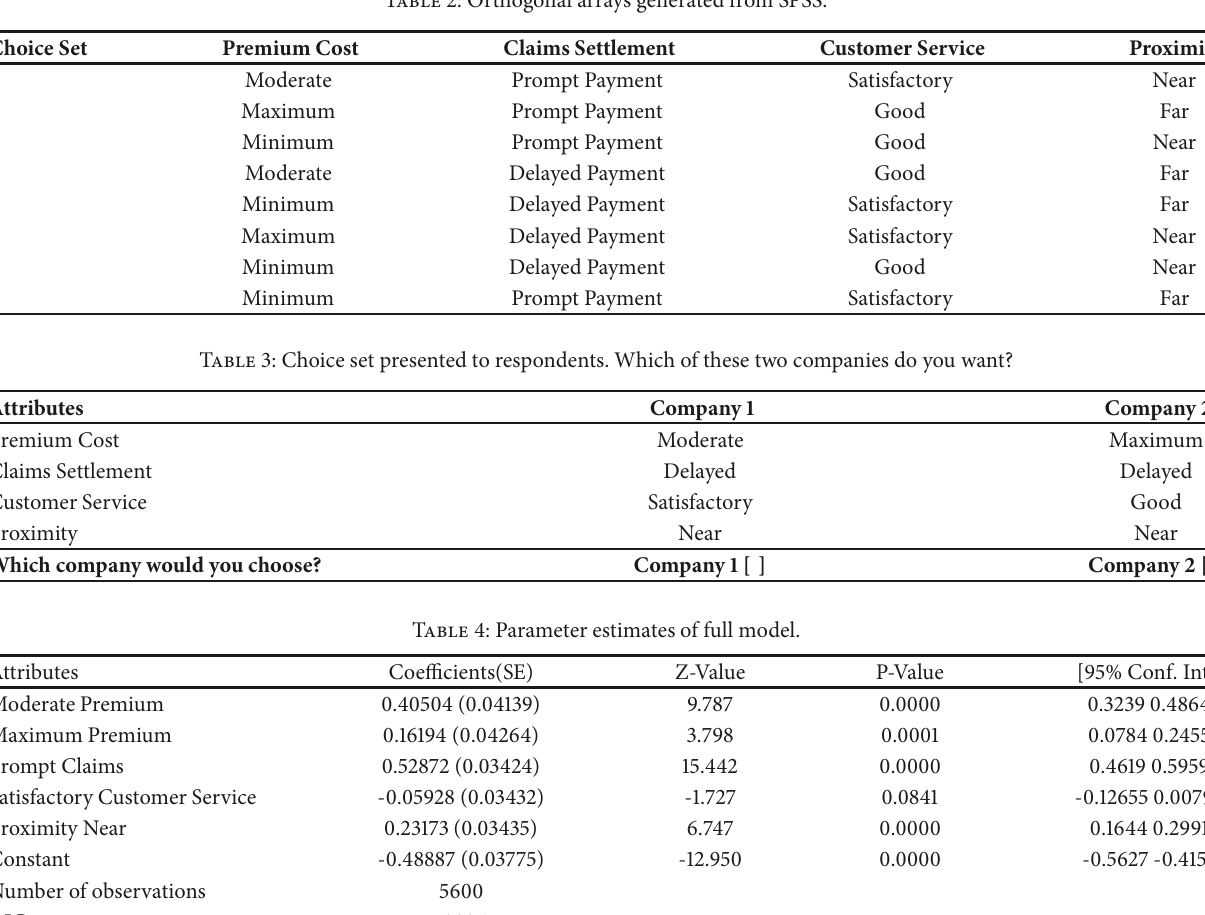
Table 2: Orthogonal arrays generated from SPSS.